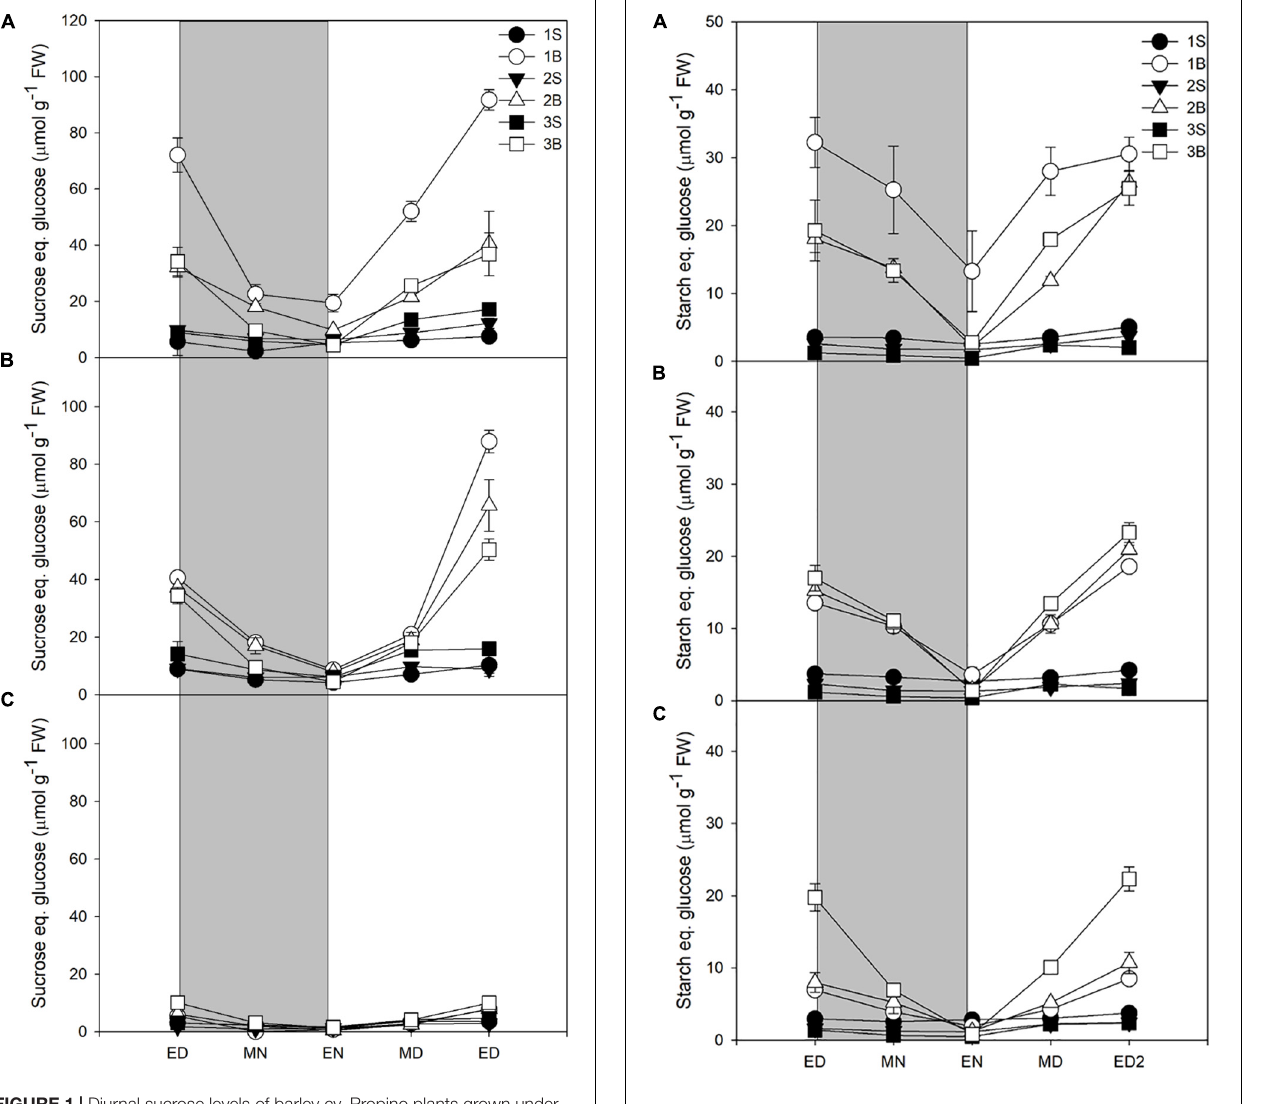
Despite a low consumption of malate pool during the night, malate was either the second (HL and ML) or the main C contributor to night consumption (LL, Table 3 ). For all light treatments, malate levels were higher in the third sheath compared to the sheaths of first and second leaves.